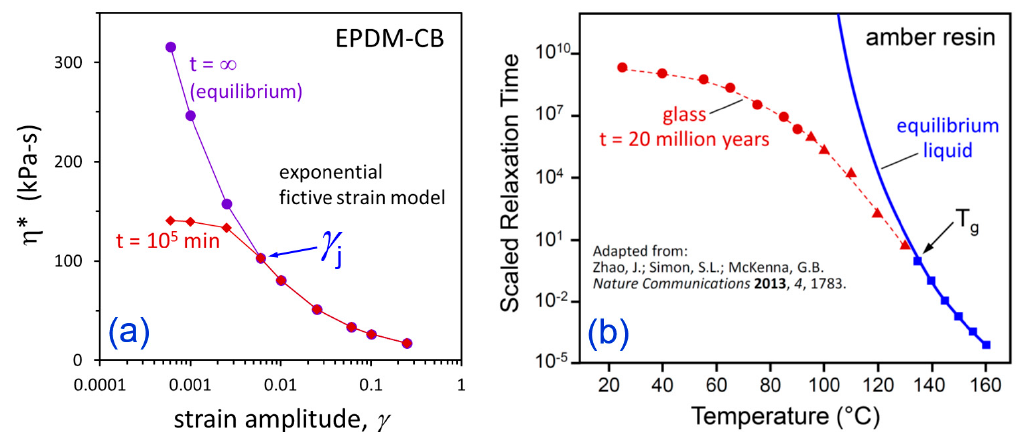
Figure 12. Comparison of departure from equilibrium as strain amplitude is decreased for EPDM-CB ( a ) with departure from equilibrium liquid behavior as temperature is decreased for 20-million-year-old amber resin glass from Zhao, Simon, and McKenna [54] ( b ).